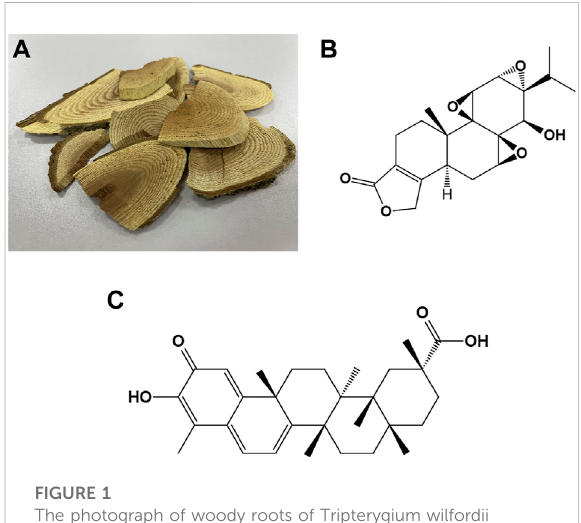
FIGURE 1 The photograph of woody roots of Tripterygium wilfordii Hook. f. and the chemical structures of triptolide and celastrol (A) The photograph of woody roots of Tripterygium wilfordii Hook. f. (B) Chemical structure of triptolide. (C) Chemical structure of